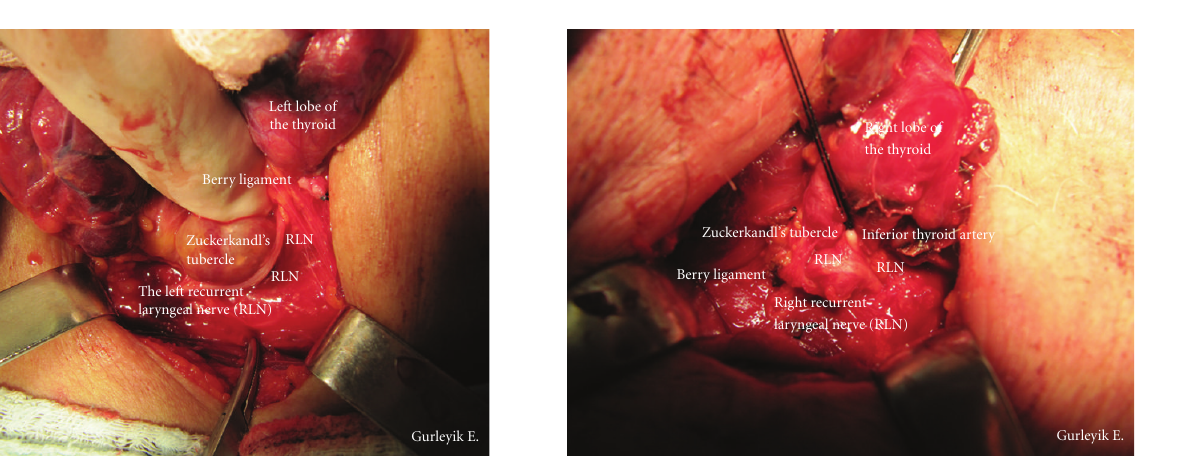
Figure 1: Enlarged tubercle of Zuckerkandl (Case 1) placed between the trachea and the left RLN. The distal part of the RLN was displaced laterally.